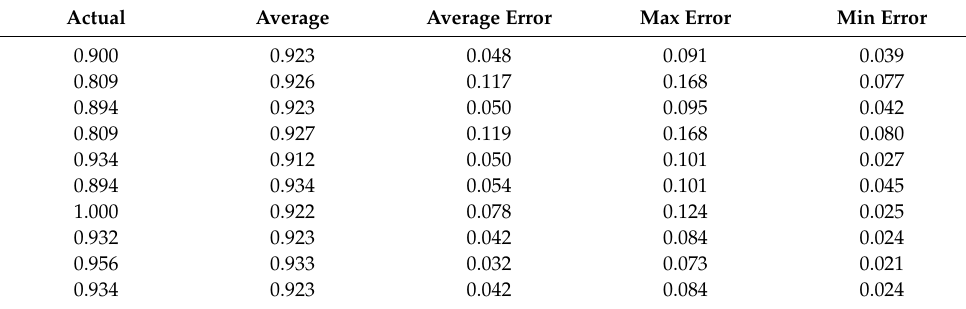
Table A95. Set 2, trials 11–20 data (single 0.5 PR value).